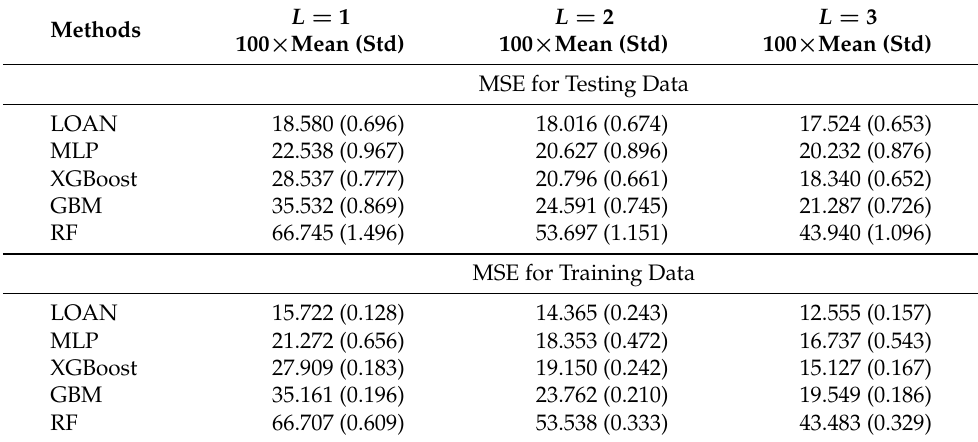
Table 5. Comparison of the number of hidden layers in LOAN and existing regressors based on CHP data.